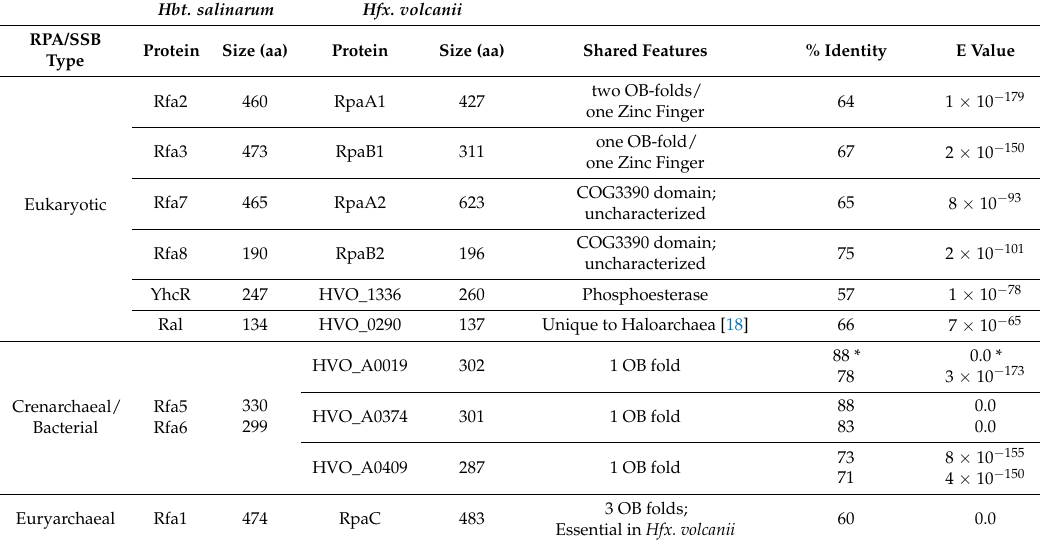
Table 1. Halobacterium salinarum and Haloferax volcanii replication protein A (RPA)/single-stranded DNA binding (SSB) protein homologues, shared features, and percent